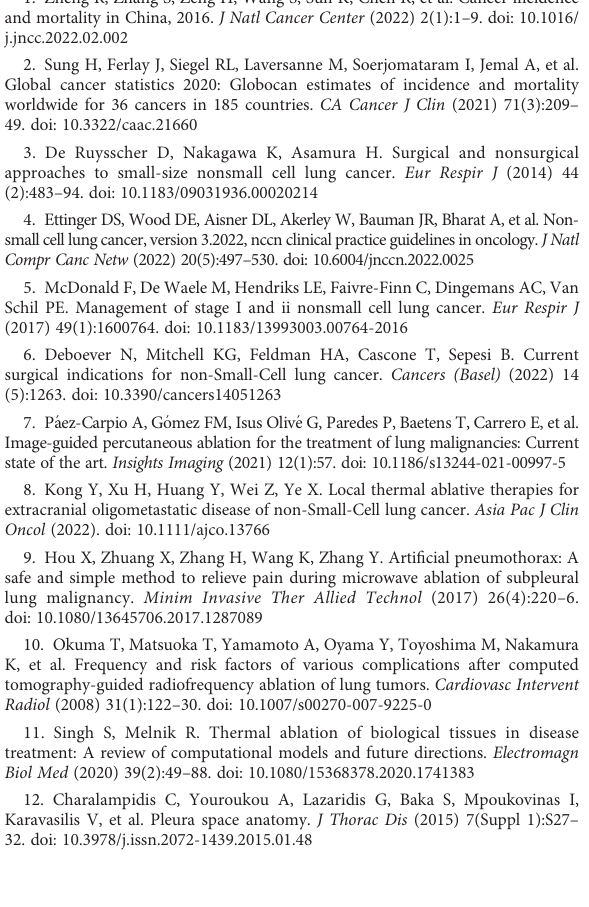
SUPPLEMENTARY TABLE 2 Differences in VAS between single and dual antennas in each